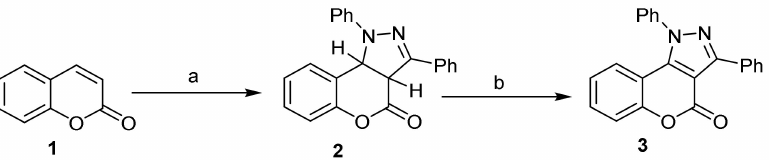
Scheme 1. Cycloaddition of diphenylnitrilimine to coumarin. Reagents and conditions. ( a ) diphenyl- nitrilimine (DPNI), benzene, TEA, compound 2 , 65% yield, compound 5 , 65% yield; ( b ) lead tetraac- etate, dichloromethane, r.t., 12 h, 83%